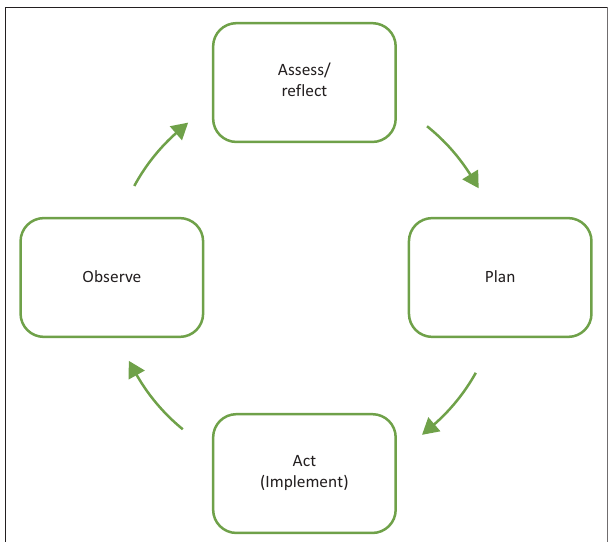
FIGURE 1: The action research